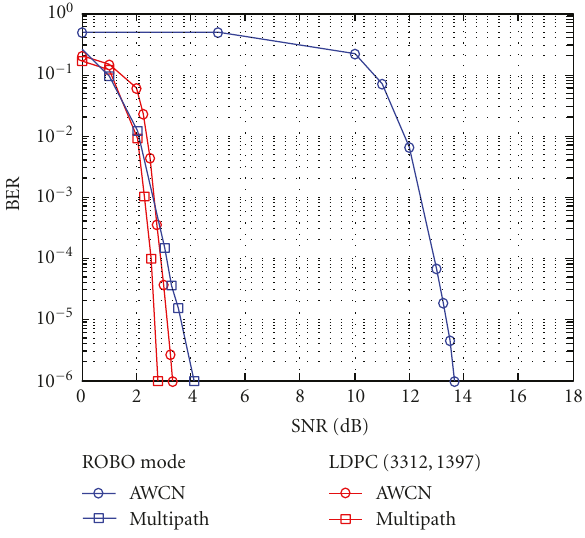
Figure 9: Measured and theoretical post-FFT variance of clipped noise over AWCN channel ( A = 0 . 1, GIR = 0 . 1).